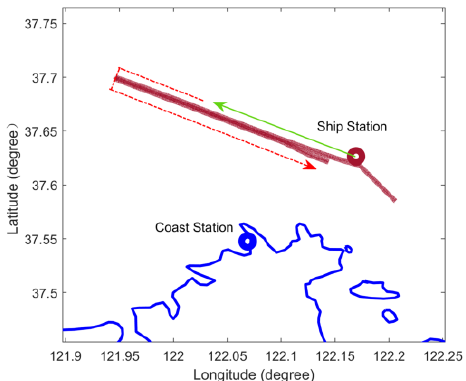
Figure 24. Location of coast-based radar station and navigation route of the ship.